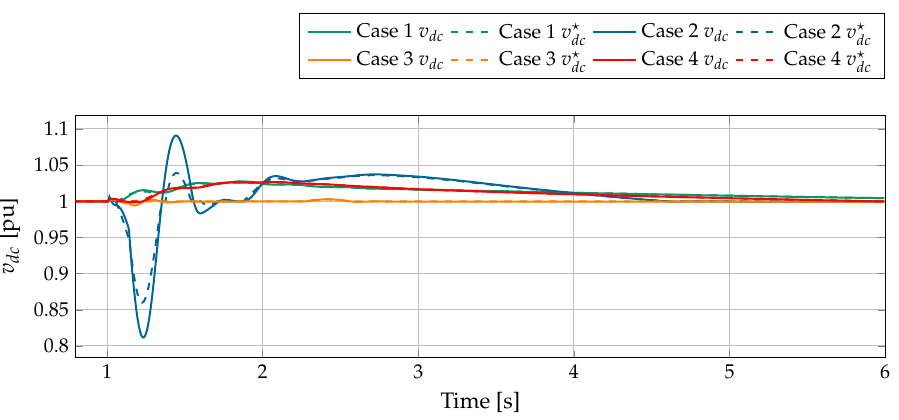
Figure 12. Response of the DC-link voltage for the